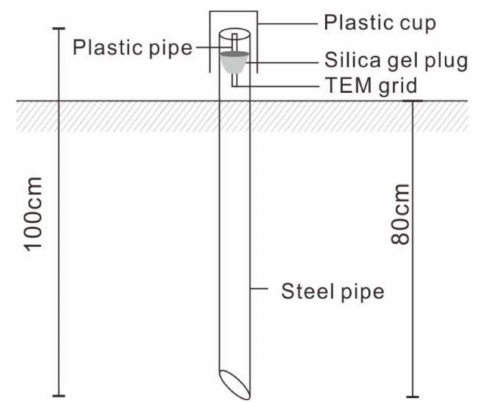
Figure 3. Sketch of the collector for nanoparticles carried by ascending gas flow. The Yangbadi village, the Nei Monggol Autonomous Region (China), 10 km